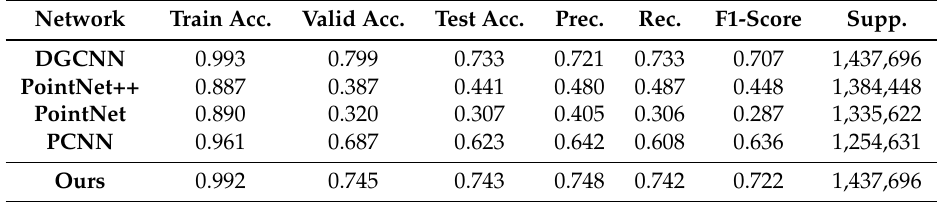
Table 3. The scene was divided into 3 parts: Train, Validation, Test. In this table, we can see the average of the metrics calculated on the different parts: accuracy for Train, Validation and Test; precision, recall, F1-score and support for the Test.